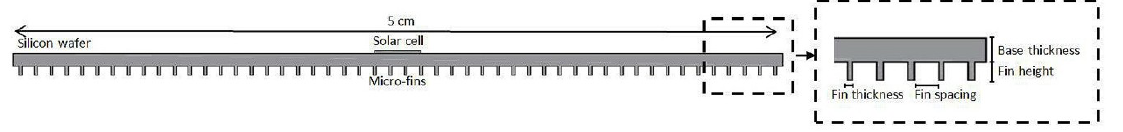
Figure 8. Cross-sectional view of the micro-finned silicon wafer and zoom on the fins [73]. Energies 2018 , 11 , x FOR PEER REVIEW